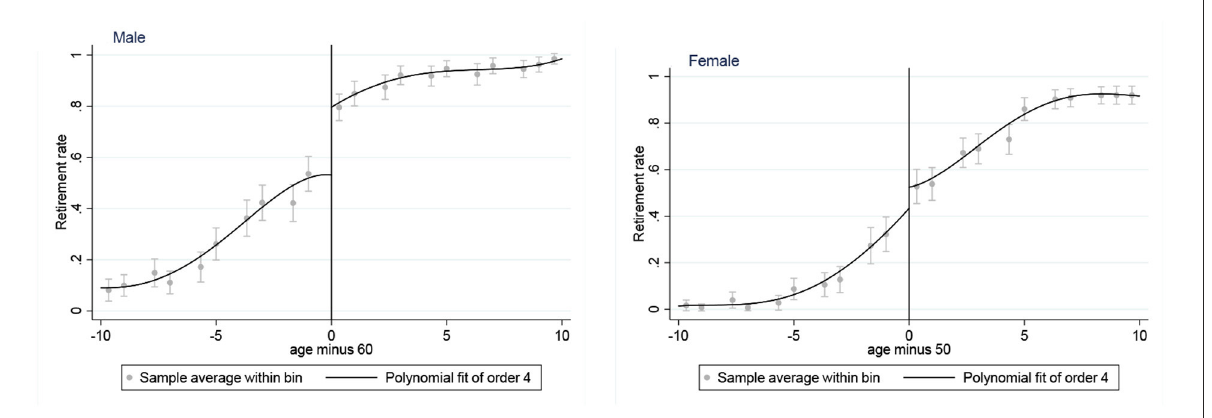
schedule of the workday, sedentary behavior is measured the